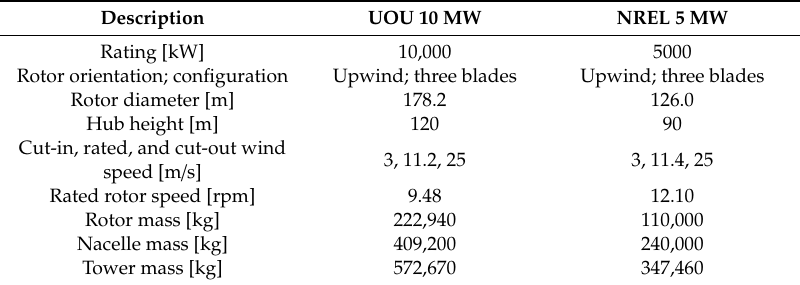
Figure 1. Model test procedure of the University of Ulsan (UOU) 10 MW floating offshore wind turbine (FOWT). Table 1. UOU 10 MW Wind Turbine